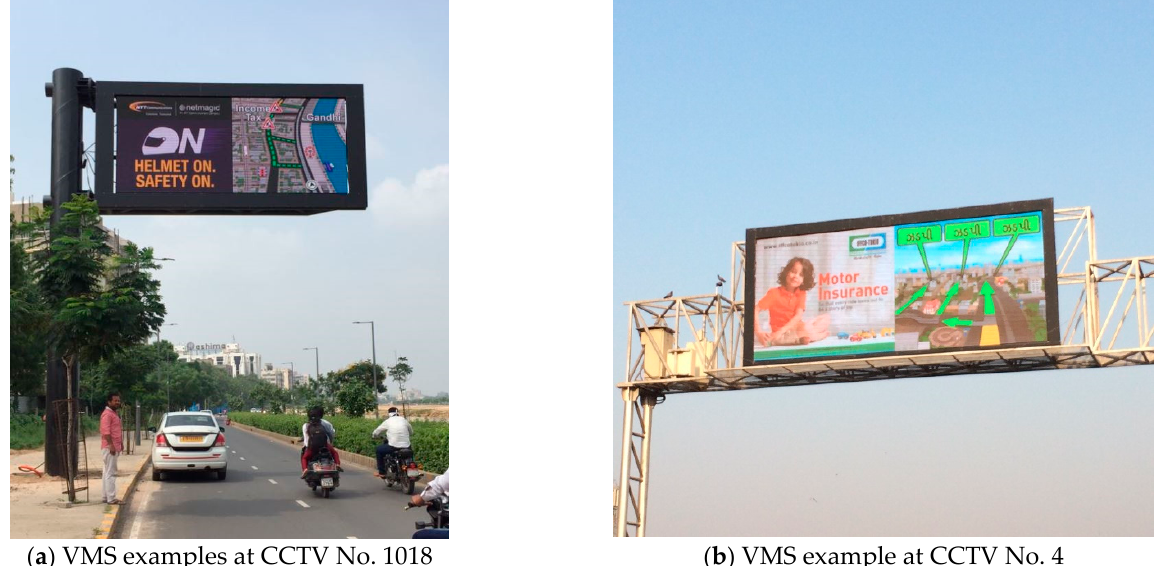
Figure A1. Example of variable message sign (VMS) in Ahmedabad city.